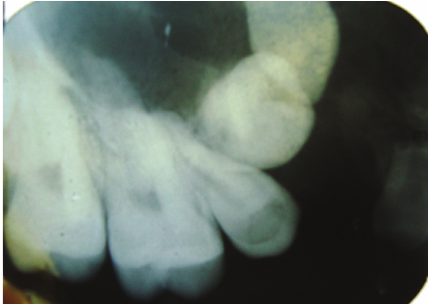
Figure 2: IOPA showing diffuse radiolucency in the region 15, 16, overretained 53 and crowns of 13, 14.